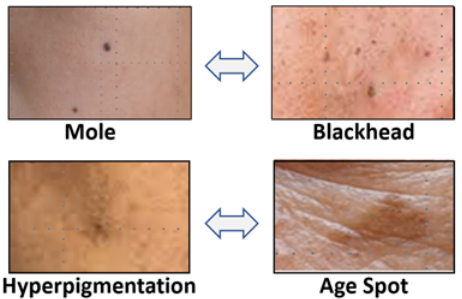
Figure 3. Appearance similarity among 4 different facial skin problem types.